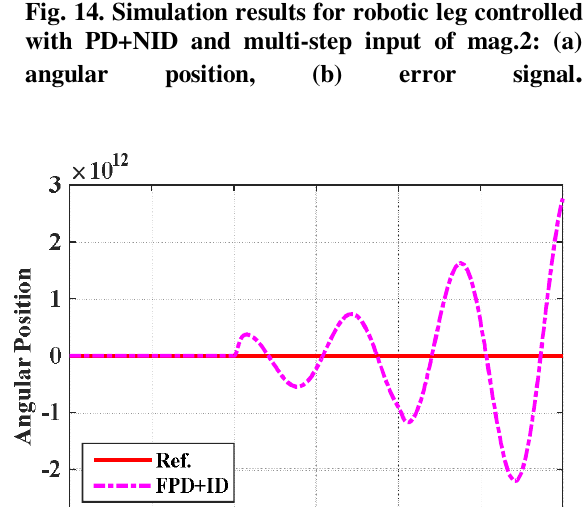
Fig. 16. Simulation results for robotic leg controlled with FPD+NID and multi-step input of mag.2: (a) angular position, (b) error